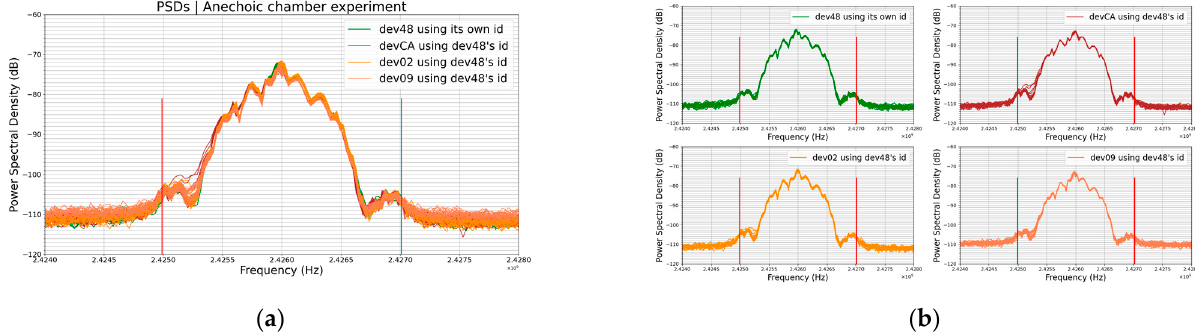
Figure 9. ( a ) PSDs of four different BLE devices using the same identifier (the one of dev48) and, thus, always transmitting exactly the same data. Graph ( a ) plots are an overlapping of graph ( b ) four groups of plots.